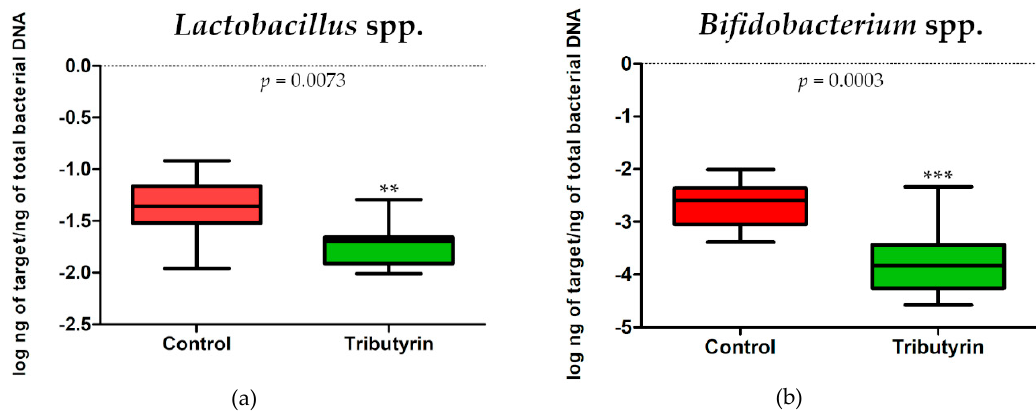
Figure 3. ( a ) Enterobacteriaceae abundance expressed as log ng of target/ng of total bacterial DNA in the faecal samples of the control group and in the group of piglets fed a diet supplemented with 0.2% tributyrin. ( b ) E. coli abundance expressed as log ng of target/ng of total bacterial DNA in the faecal samples of the control group and in the group of piglets fed a diet supplemented with 0.2% tributyrin.